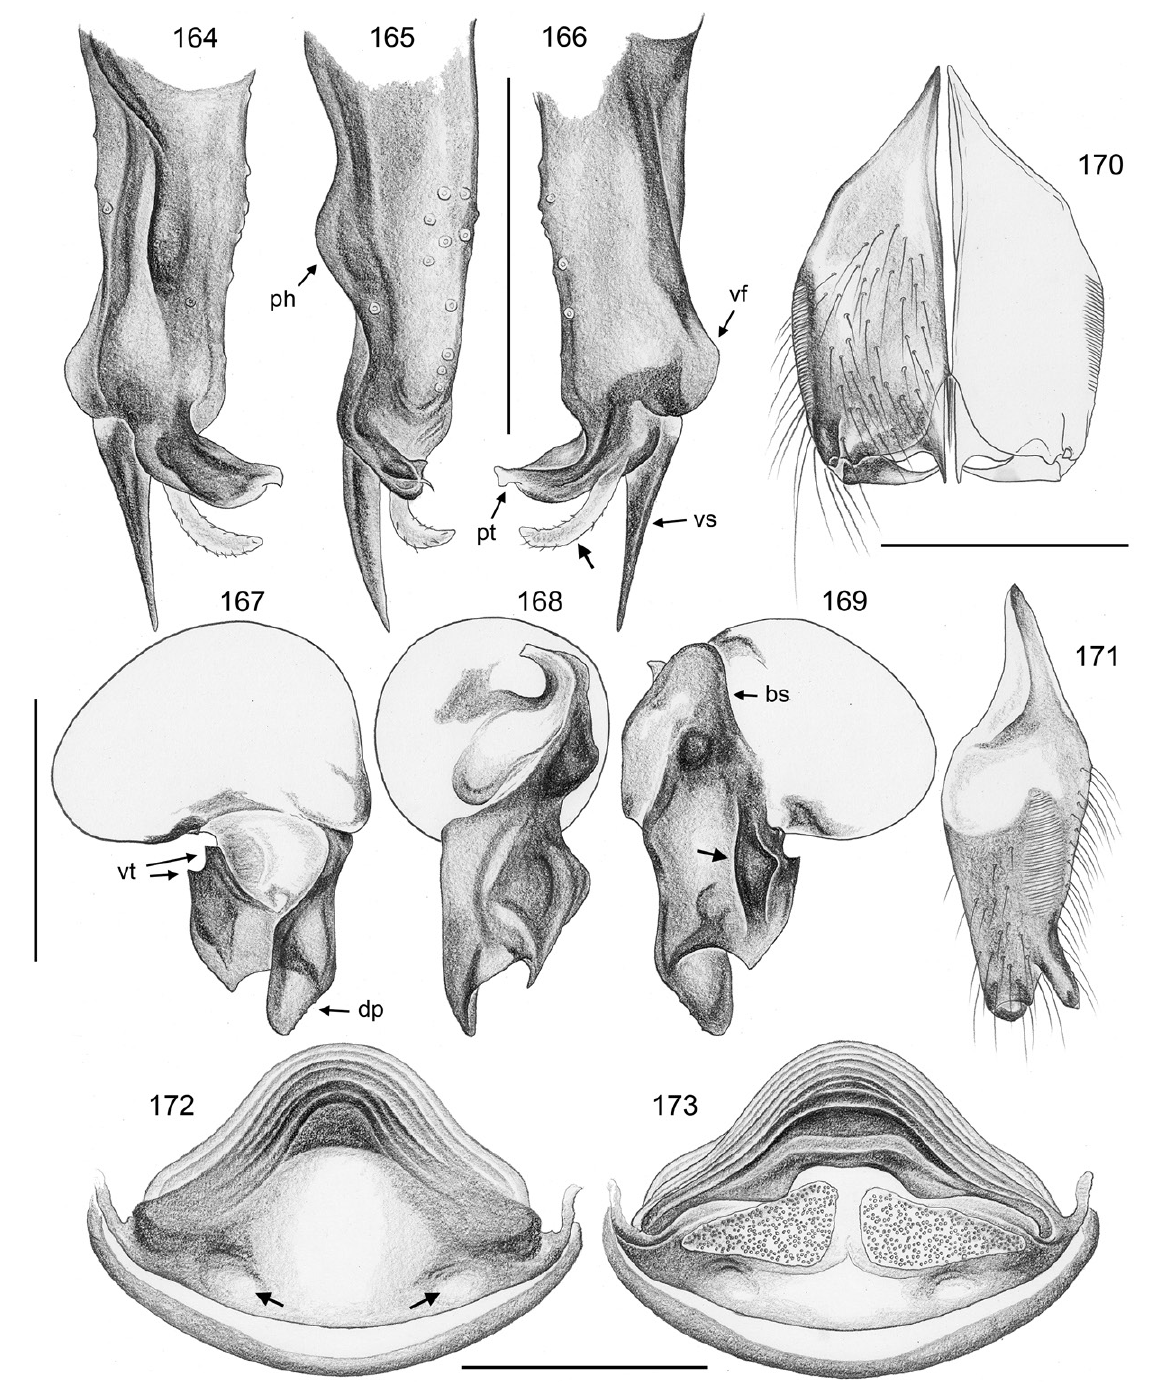
Figs 164–173. Maghreba amezyan gen. et sp. nov.; male and female from Morocco, between Lakhssas and Bouizakarne (ZFMK Ar 22353, Ar 22354). 164–166 . Left procursus, prolateral, dorsal, and retrolateral views; arrow: transparent process. 167–169 . Left genital bulb, prolateral, dorsal, and retrolateral views; arrow: deep pocket. 170–171 . Male chelicerae, frontal and lateral views. 172–173 . Cleared female genitalia, ventral and dorsal views; arrows: pockets (pits). Abbreviations: bs = basal sclerite; dp = dorsal process; ph = prolateral hump; pt = procursus tip; vf = ventral flap; vs = ventral sclerite; vt = ventral teeth. Scale bars = 0.5